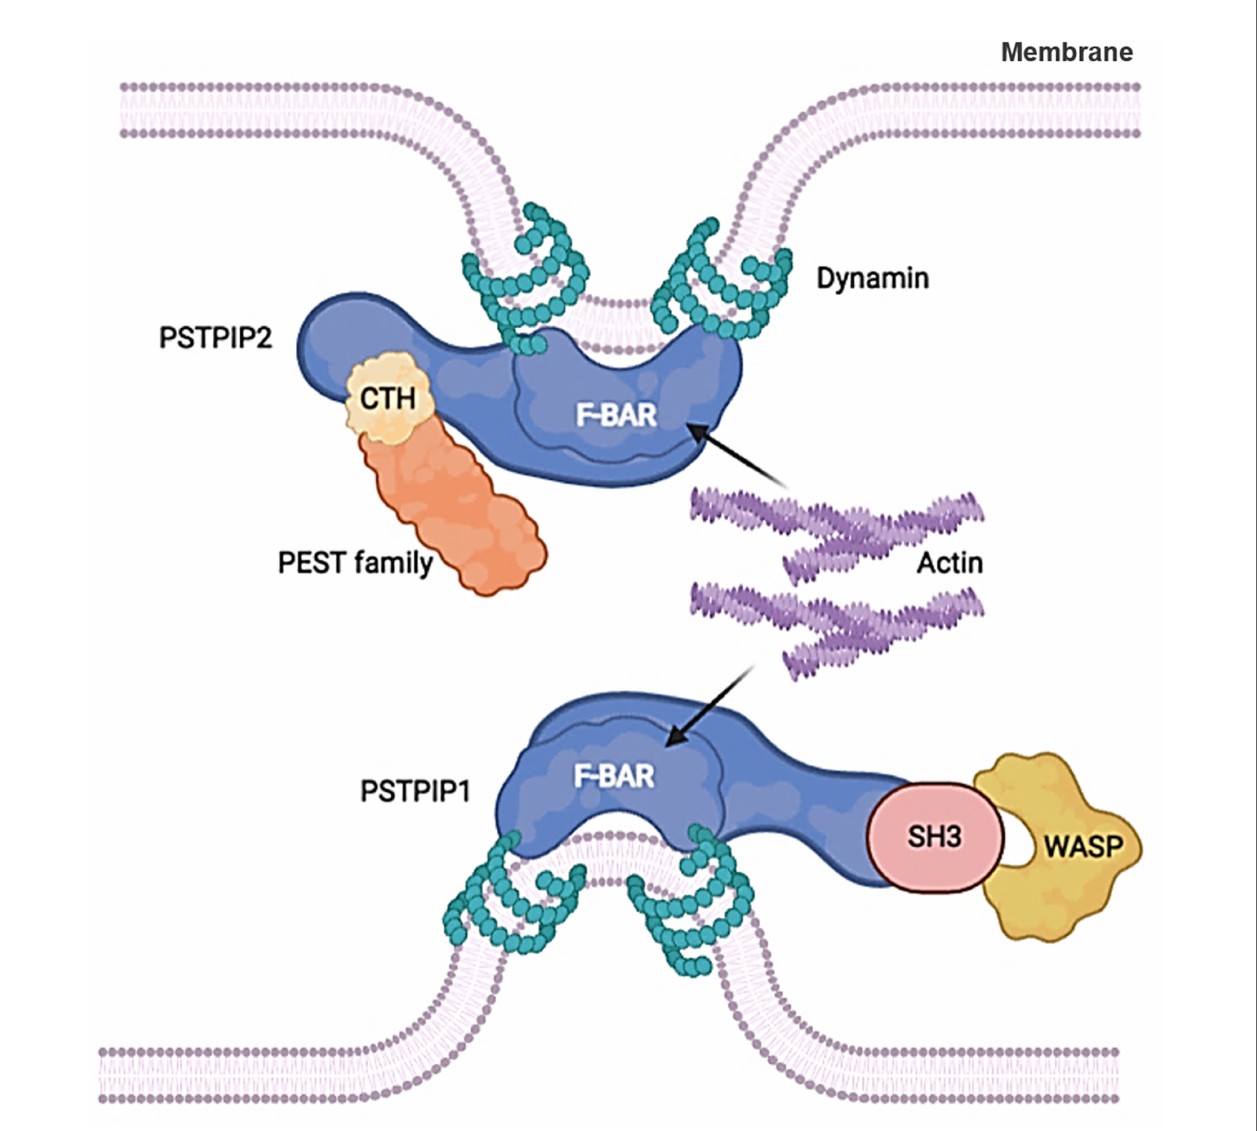
FIGURE 1 | F-BAR proteins regulate membrane curvature by binding to cell membrane phospholipids. PSTPIP2 lacks the SH3 domain that is indispensable for interaction with WASP compared with PSTPIP1. Instead, it interacts with the C-terminal homology domain of the PEST family